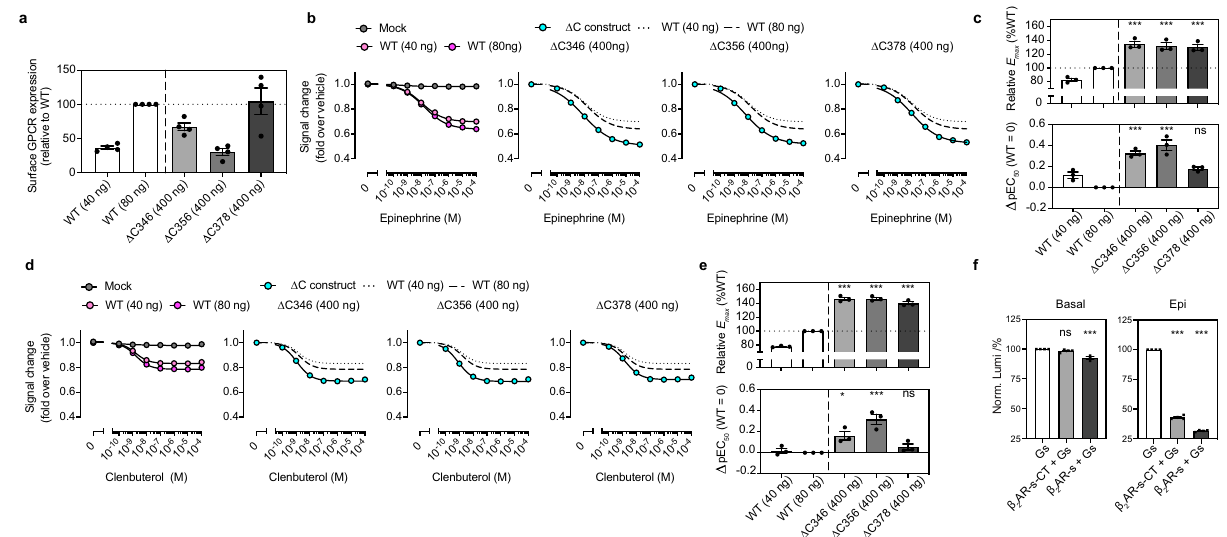
Fig. 1| The β 2ARCT autoinhibitsagonist-stimulatedreceptoractivation.a Cell surface expression measured by the fl ow cytometry analysis. Note that amount of plasmidtransfectionofWT β 2 ARwastitrateddownto40ngand80ngtoadjustthe expression levels equivalent to the Δ CT β 2 AR. Data are mean±s.e.m. of 4 inde- pendentexperiments. b Concentration-responsecurvesofepinephrine-inducedGs heterotrimer dissociation in cells. The β 2 AR-mediated Gs dissociation was mea- sured by the NanoBiT-G-protein dissociation assay, stimulated by full agonist epi- nephrine in WT and the three Δ CT receptors. Data are mean±s.e.m. of 3 independentexperiments. Ν otethatinmanydatapointserrorbarsaresmallerthan the size of symbols and thus are not visible. c The relative E max and Δ pEC 50 para- meters of the Gs dissociation responses stimulated by epinephrine in ( b ). d Partial